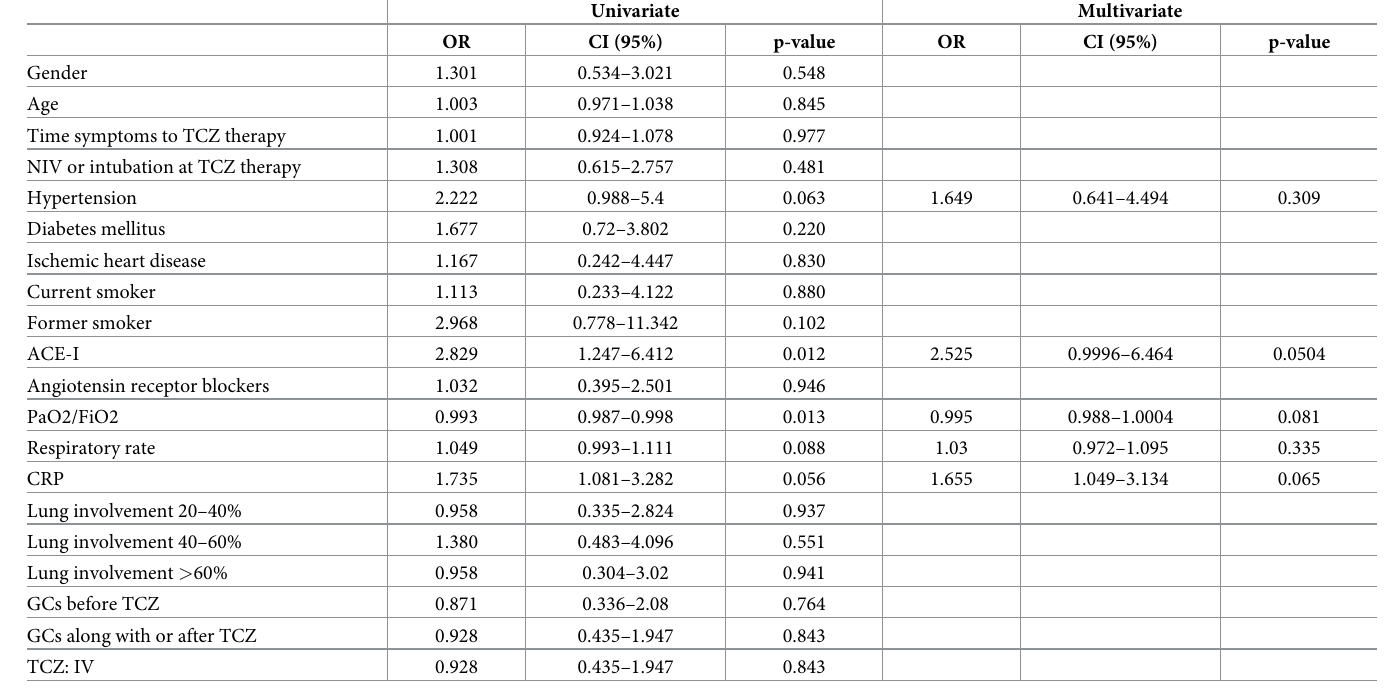
Table 2. Clinical, serological and radiological features associated with NON response to tocilizumab